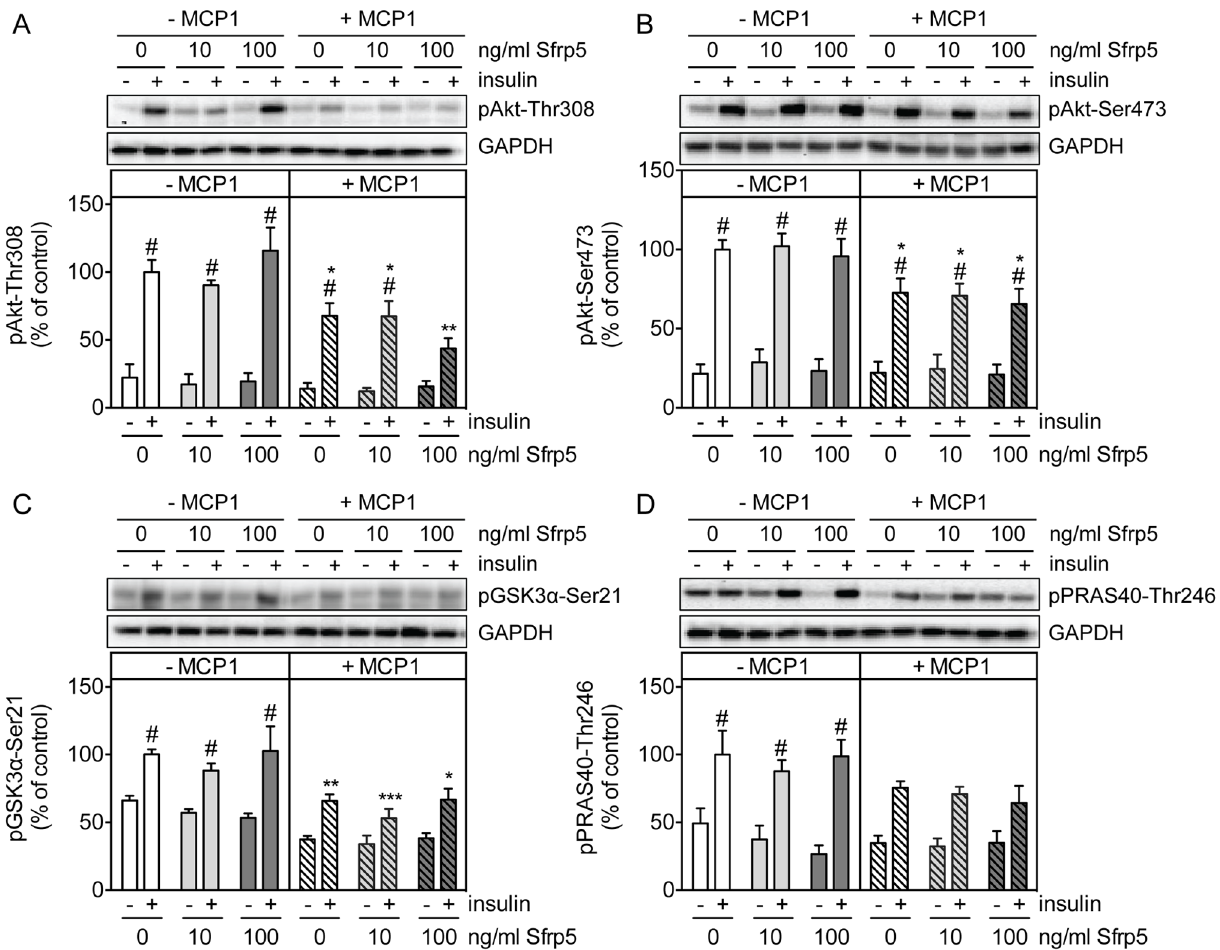
Figure 6. Effect of Sfrp5 on insulin signaling in primary human skeletal muscle cells. Primary human skeletal muscle cells were kept untreated, exposed to Sfrp5 for 24 h, or to 2 ng/ml MCP-1 for 18 h with or without a 4 h preincubation with 100 ng/ml Sfrp5. Then, when indicated ( + ) cells were stimulated with insulin (10 min; 100 nM). Cell lysates were analyzed for phosphorylation of Akt-Thr308 (A), Akt-Ser473 (B), GSK3 a -Ser21 (C) and PRAS40-Thr246 (D) by Western blotting. Phosphorylation signals were normalized for GAPDH protein abundance and expressed as mean 6 standard error of the mean of five independent experiments using cells from different donors. The values obtained for Sfrp5-untreated, insulin- treated cells were considered as control and set at 100%. Differences among groups were calculated by two-way ANOVA followed by Bonferroni multiple comparison analysis. # , indicates p , 0.05 for the effect of insulin stimulation; ***, p , 0.001; **, p , 0.01; *, p , 0.05 versus untreated cells. (Figure 2D-E). Levels of IL-15 were below the detection limit under all experimental conditions for hSkMC.